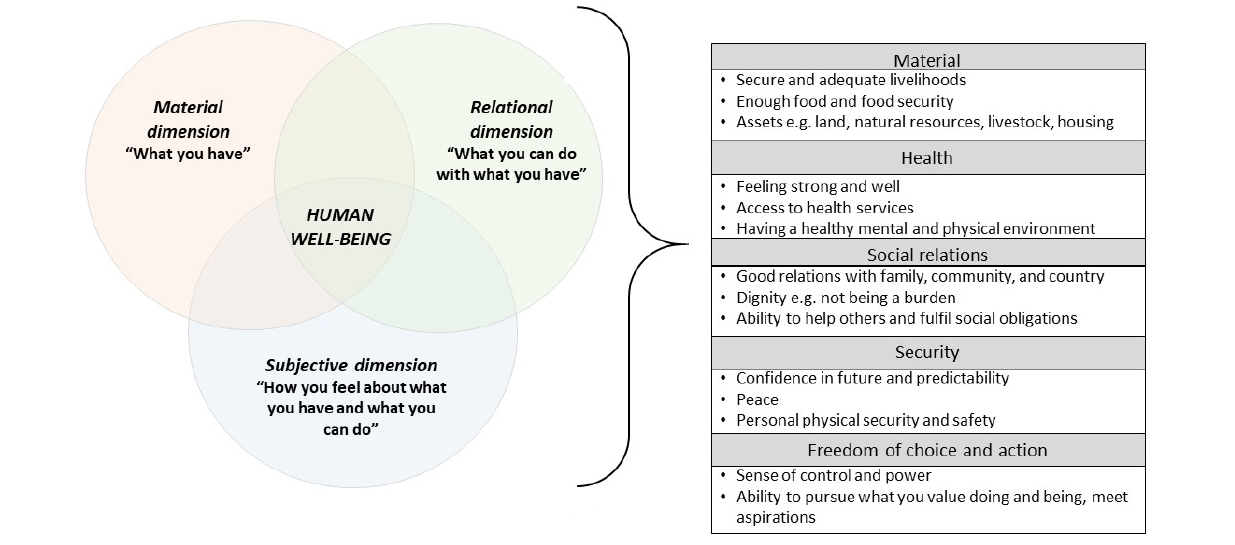
Fig. 1. Framework for researching human well-being used in our study, based on McGregor and Sumner (2010) and drawing on the World Bank’s “;Voices of the Poor” research (Narayan et al. 2000). Well-being encompasses five primary domains, which can each be seen through the lens of the three